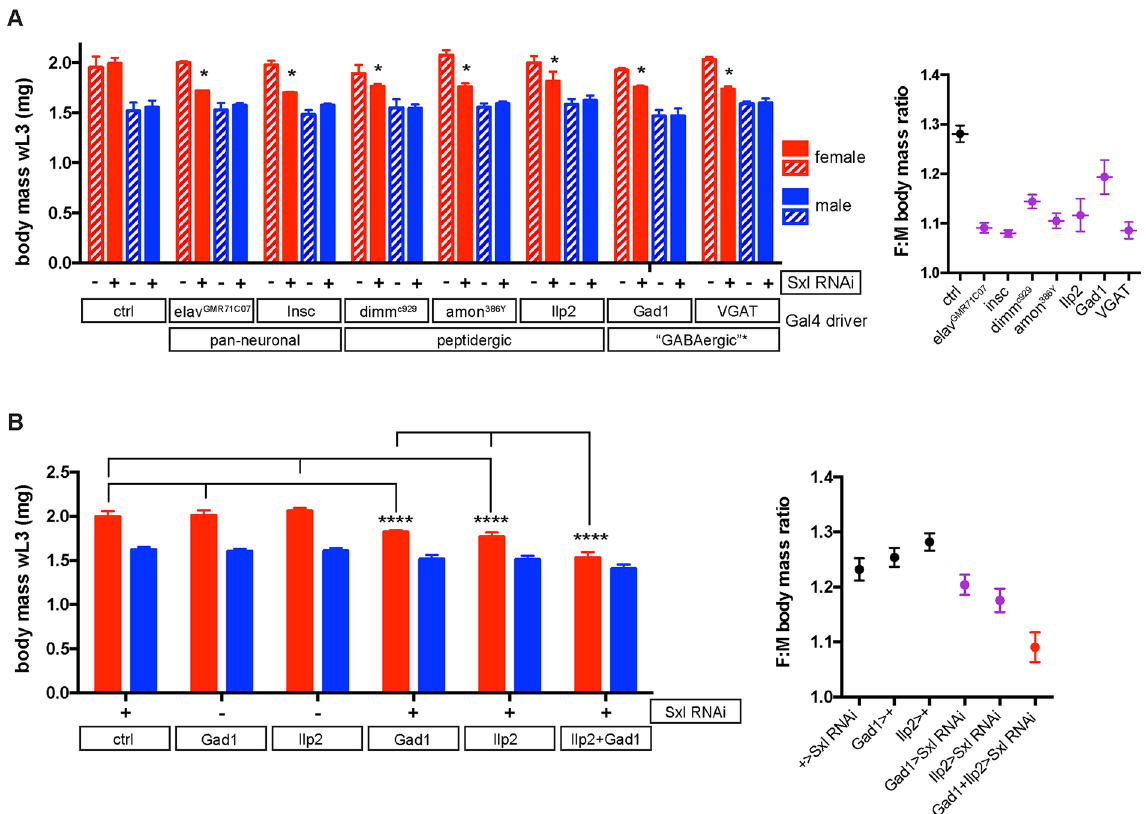
Fig 5. Sex-lethal ( Sxl ) is required in insulin-producing cells (IPCs) and Gad1-Gal4 neurons to control sexual size dimorphism (SSD). (A) Gal4-driver screen identifies7 pan-neuronal, broad peptidergic( dimm c929 , amon 386Y ), IPC (insulin-like peptide2 [ Ilp2 ]), and GABAergic * drivers with female-specific effects on body mass when combinedwith upstream activation sequence ( UAS ) -Sxl RNAi . For details and full results of screen, see S8 Fig. Left graph shows mean body mass and SD of 2–16 replicates of groupsof 3–11 larvae. Hatched bars depict controls lackingthe Sxl RNAi transgene, identifiedby the CyO , Dfd-YFP balancer, except for Gad1-Gal4 controls, which also include CyO , Dfd-YFP > SxlRNAi larvae. In all cases, * p < 0.001 from respective no-drivercontrols using 2-way ANOVA with multiplecomparisons. Right graph shows mean female to male (F:M) body mass ratios and SEMs for the Gal4 driver hits that decreaselarval SSD. Expression analysisof elav c155 -Gal4 and the other driver hits in this screen suggests that there is no shared secondary site of larval expressionoutsidethe nervoussystem (S1 Table). * Note that the 2 “GABAergic” drivers ( Gad1-Gal4 and VGAT-Gal4 ) show only partiallyoverlappingexpressionwith GABA+ neurons(see S1 and S2 Images). (B) Ilp2-Gal4 and Gad1-Gal4 act additivelyto decrease female larval body mass via Sxl knockdown. Left graph shows mean body mass and SD of 3–4 replicates of groupsof 6–10 larvae. Right graph shows mean F:M body mass ratios and SEMs. Knockdown of Sxl using both Ilp2-GAL4 and Gad1-Gal4 decreases female body mass and SSD more strongly than with each driver alone.Note that for Ilp2 > SxlRNAi and Ilp2 + Gad1 > SxlRNAi genotypes, results were pooledfrom 3 independent recombinants of Ilp2-Gal4 , UAS-Sxl RNAi 1 , each crossed to a no-driver control or to Gad1-Gal4 ,respectively. **** indicates p < 0.0001 using 1-way ANOVA with multiplecomparisons. The underlyingdata for this figure can be found in S1